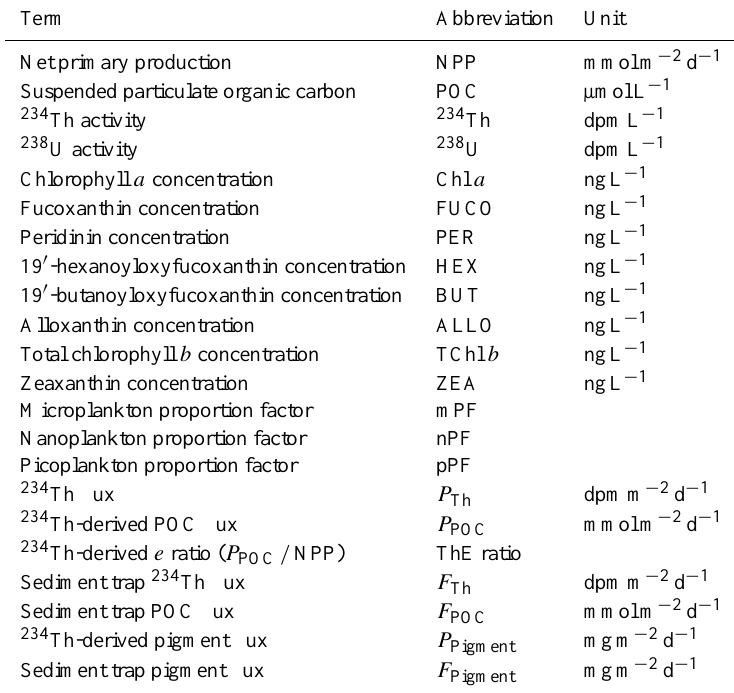
Table 1. Summary of abbreviations used.